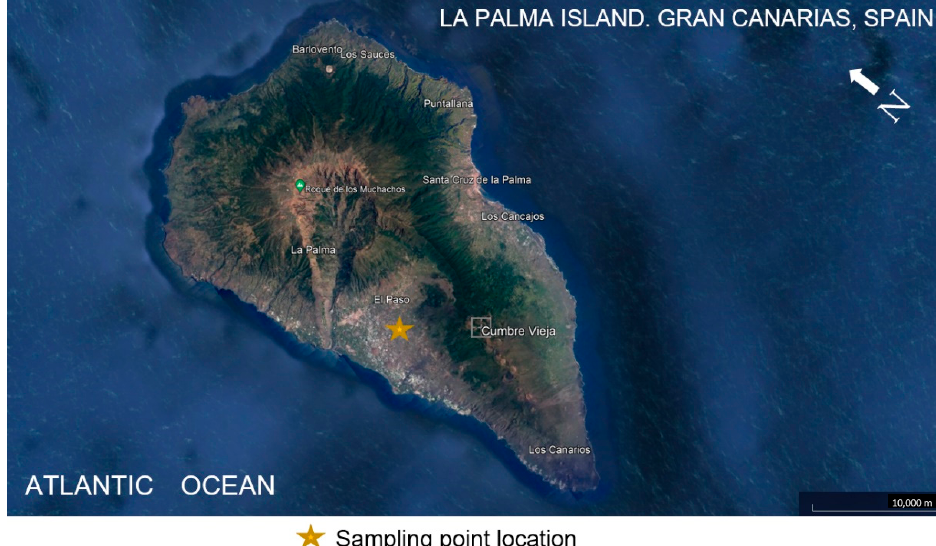
Figure 2. Map of the of the sampling point location